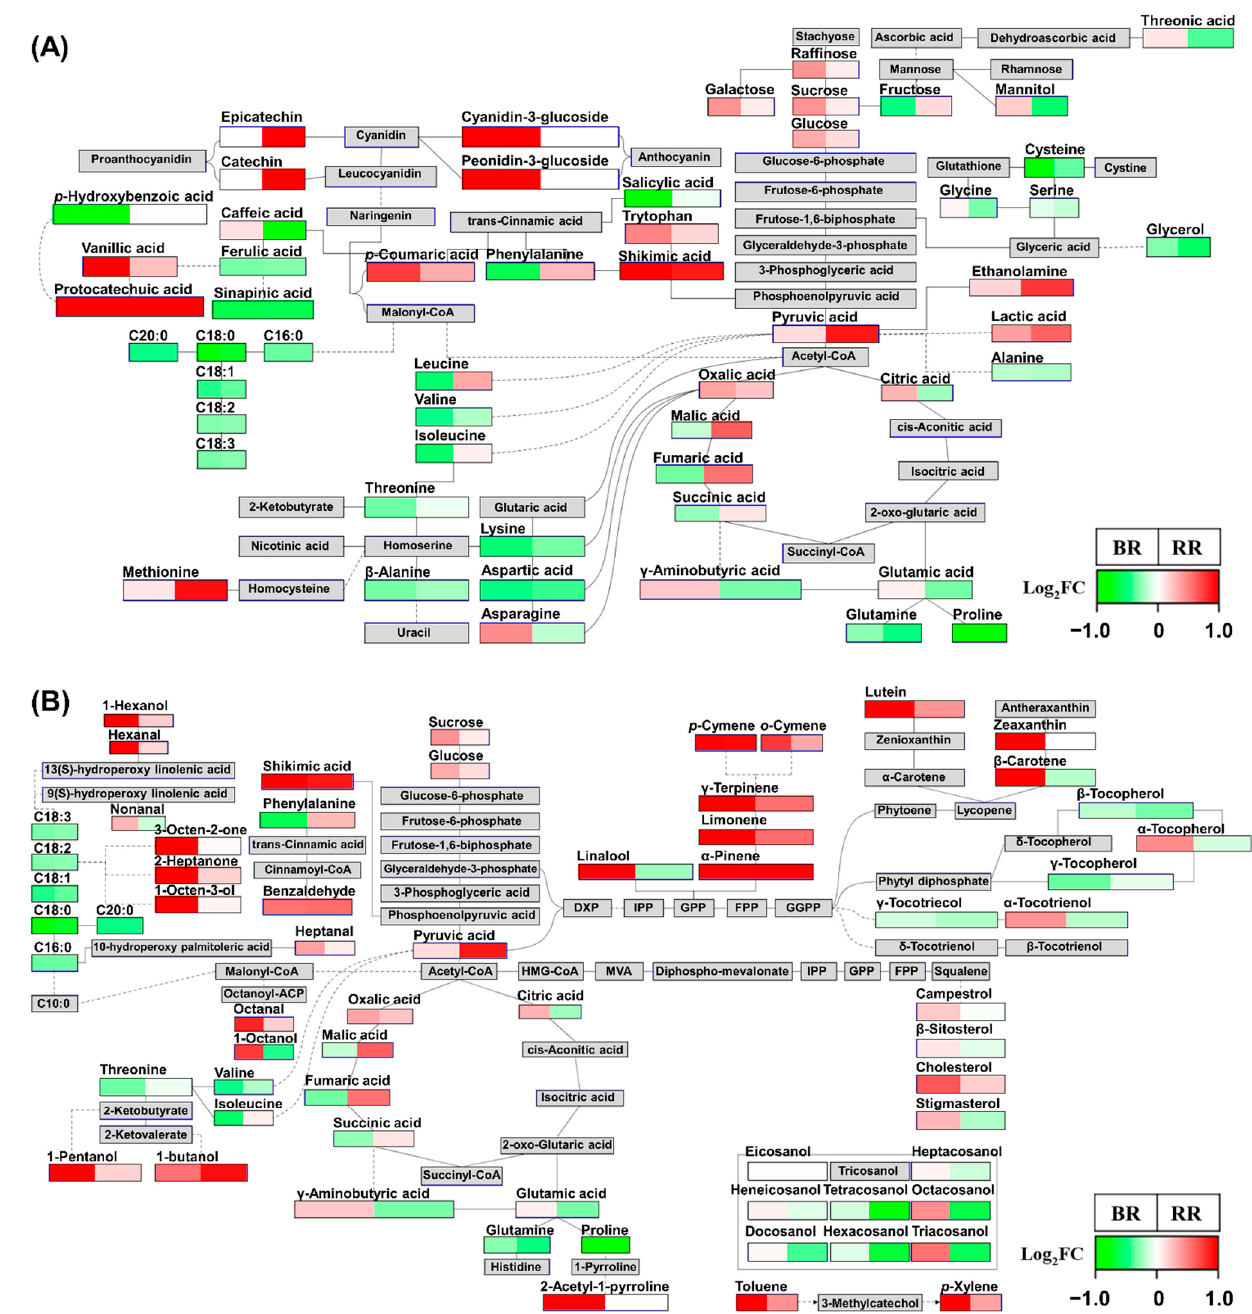
Figure 4. Metabolic pathway diagrams visualized by PathVisio 3. Detailed metabolic pathway diagrams of amino acids, organic acids, sugars, phenylpropanoids, and fatty acids ( A ); terpenoids and volatiles ( B ). The expression data consist of log 2 -transformed fold change (FC) values (log 2 FC). A log 2 FC value range is − 1 < log 2 FC < 1. If log 2 FC value is higher than zero (indicated in red), metabolite content is higher in pigmented rice than in non-pigmented rice (WR: white rice). If log 2 FC value is less than zero (indicated in green), metabolite content is lower in pigmented rice than in non-pigmented rice. If log 2 FC value is zero (indicated in white), metabolite content is identical in pigmented and non-pigmented rice. (BR: Black Rice, RR: Red Rice).